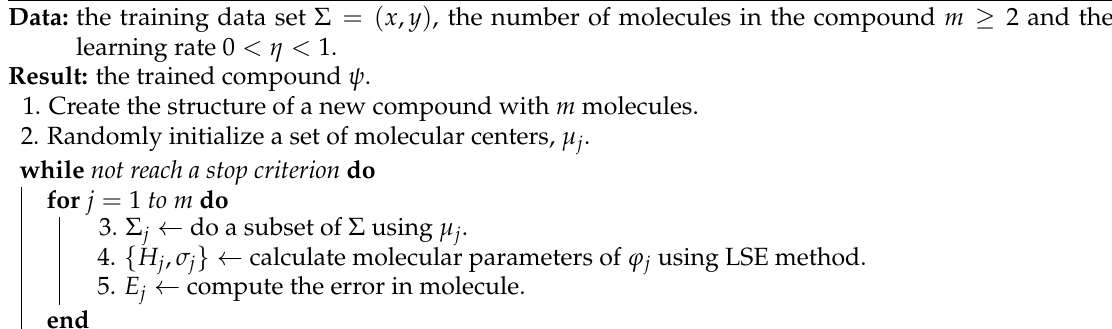
Algorithm 1 Simple AHN training